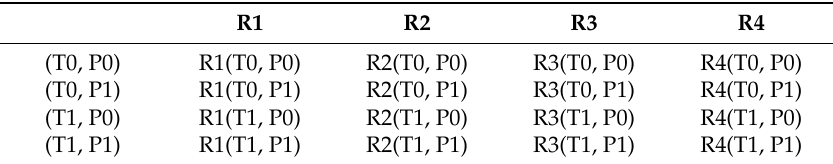
Table 1. Measurement parameters for compensation